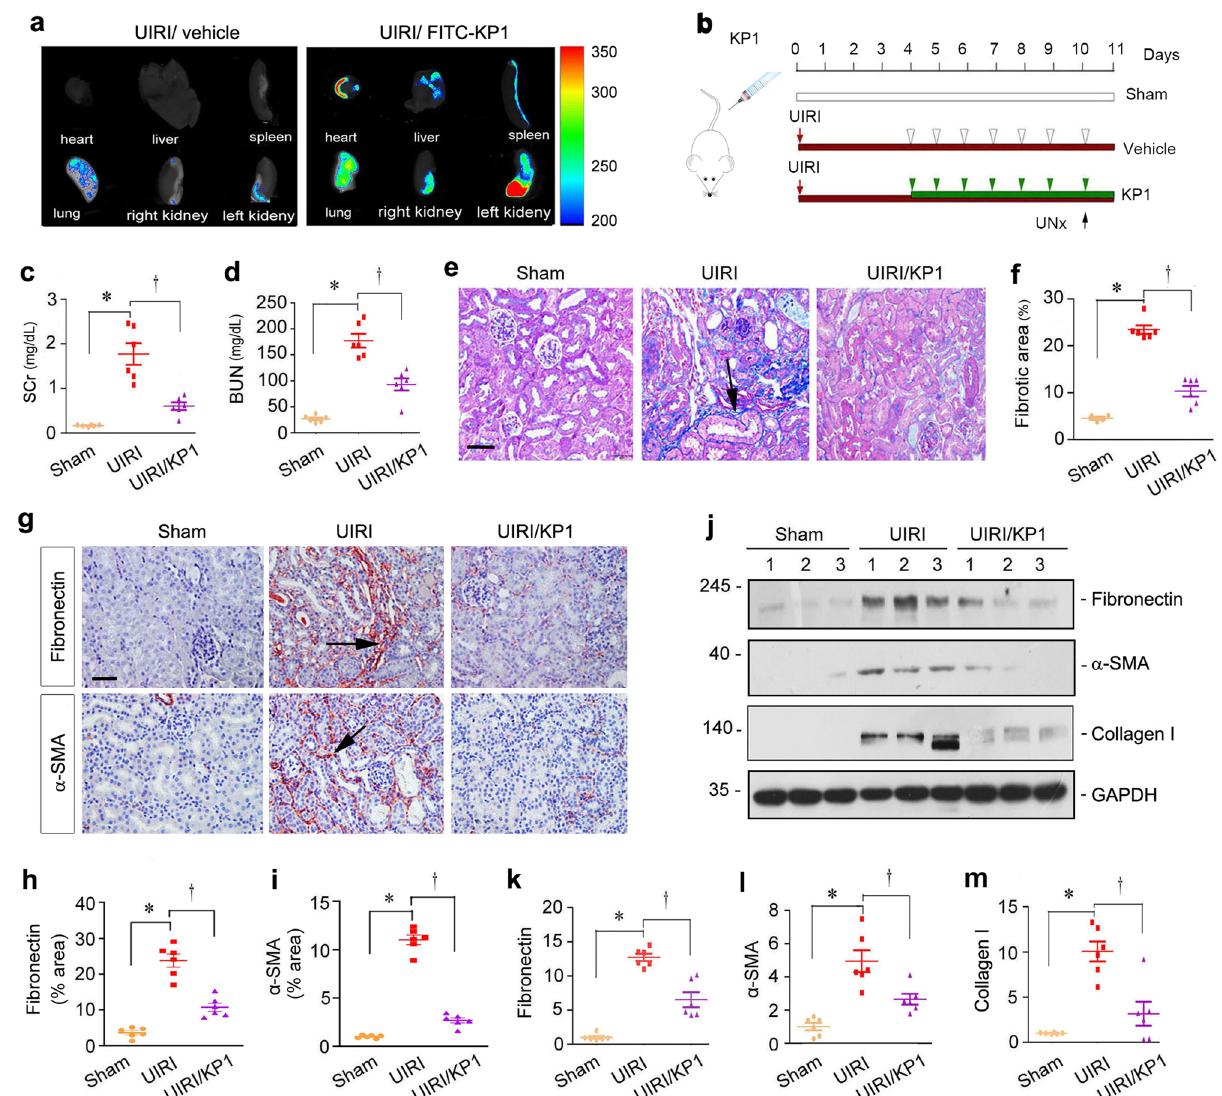
Fig. 4 KP1 preserves renal functions and ameliorates renal fi brosis in UIRI mice. a Organ imaging showed that KP1 was preferentially accumulated in the injured kidney after UIRI. Relative levels of FITC-KP1 are shown in major organs. b Schematic diagram of the experimental design. The red line indicates the duration of surgery. The green arrowheads indicate the injections of KP1 (1 mg/kg body weight), whereas white arrowheads denote the injections of vehicle (0.01 M acetic acid). c , d KP1 preserved kidney function in UIRI mice. Serum creatinine (Scr) ( c ) and blood urea nitrogen (BUN) ( d ) levels are shown. P values (from left to right): 0.003, 0.010 (Scr); <0.001, P < 0.001 (BUN). n = 6 biologically independent animals. e Representative micrographs of Masson ’ s trichrome staining in different groups. Scale bar, 50 µ m. Arrow indicates collagens deposition. f Quantitative determination of renal fi brotic lesions. P values (from left to right): <0.001, <0.001. n = 6 biologically independent animals. g Representative micrographs of immunohistochemical staining for fi bronectin and α -SMA. Scale bar, 50 µ m. h , i Quantitative data of fi bronectin and α -SMA positive area in each high-power fi eld. P values (from left to right): <0.001, <0.001 ( fi bronectin); <0.001, <0.001 ( α -SMA). n = 6 biologically independent animals. j Representative Western blot showed renal protein levels of fi bronectin, α -SMA, and collagen I in different groups. Numbers (1 – 3) indicate each individual animal in a given group. k – m Quantitative data of fi bronectin ( k ), α -SMA ( l ), and collagen I ( m ) proteins in different groups. P values (from left to right): <0.001, 0.004 ( fi bronectin); 0.003, 0.045 ( α -SMA); 0.001, 0.018 (collagen I). n = 6 biologically independent animals. * P < 0.05 versus sham; † P < 0.05 vs. UIRI alone. P values were determined by one-way ANOVA followed by Fisher ’ s LSD post hoc test ( d , f , h , i ) or Dunnett ’ s T3 test ( c , k , l , m ). Data are presented as mean values ± SEM. Source data are provided as a Source Data fi